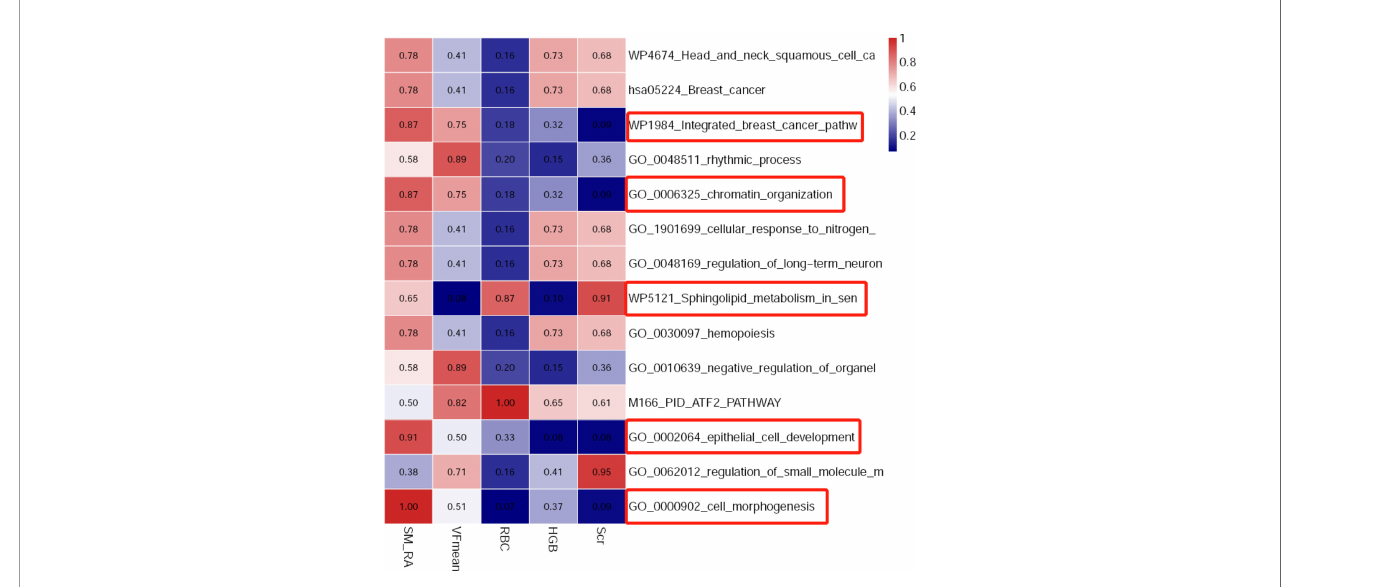
FIGURE 8 | The heat map indicating associations between related biological pathways and selected body composition features and clinical